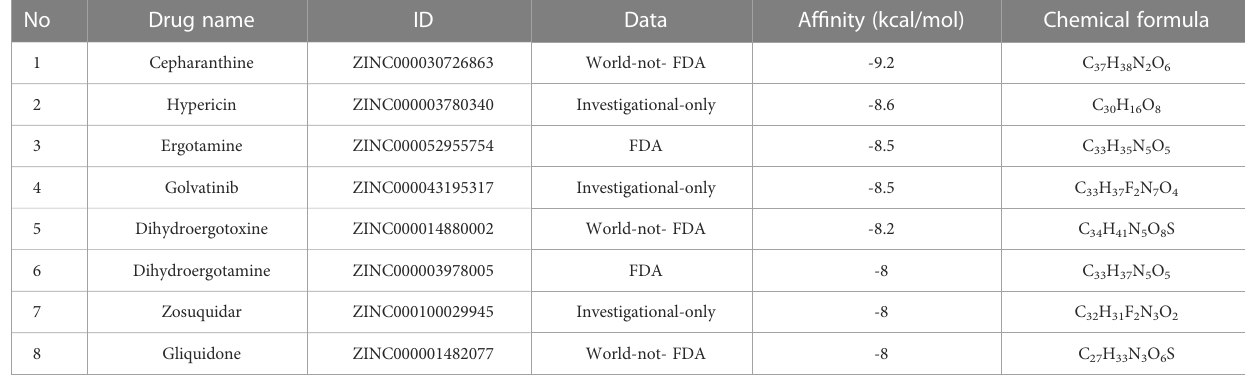
TABLE 1 Eight drugs selected from the 40S-SARS-CoV-2-Nsp1 (BQ.1) model.